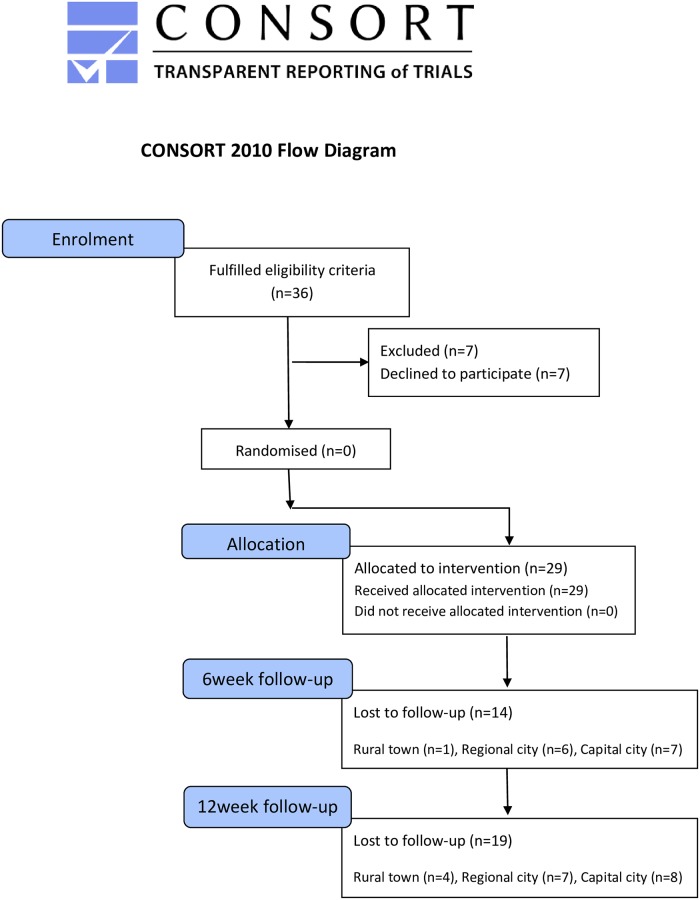
CONSORT flow diagram [38–40].